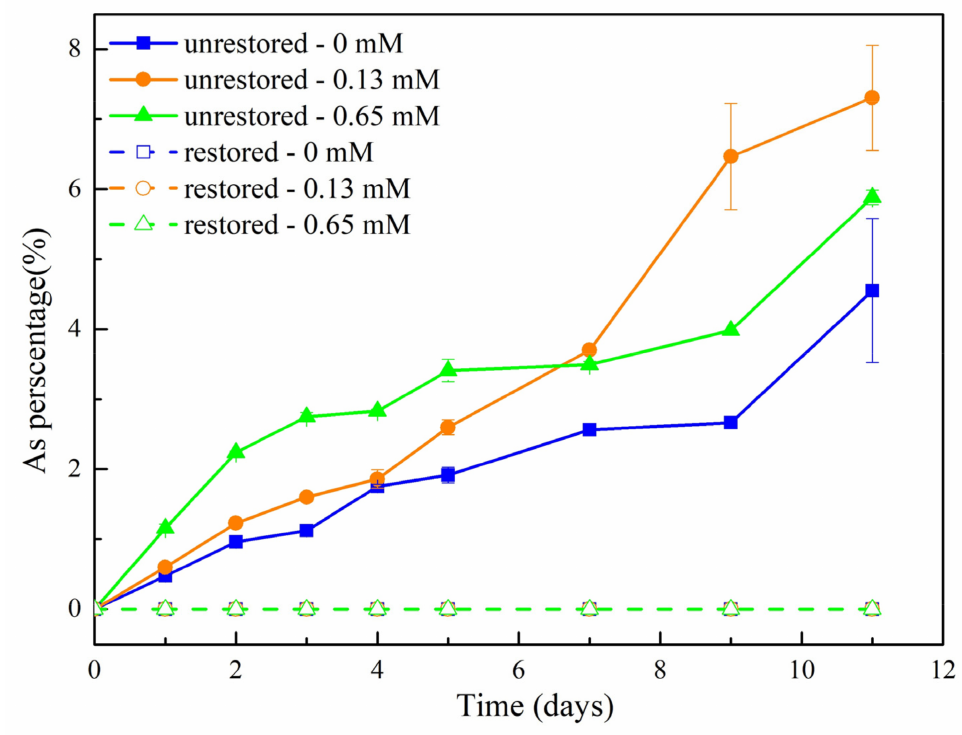
Figure 8. Dissolved As release as a percent of total As in soil under biotic conditions in restored and unrestored soils with different phosphate